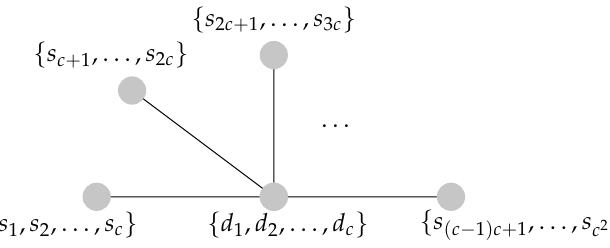
Figure 1. A worst-case instance for the transportation